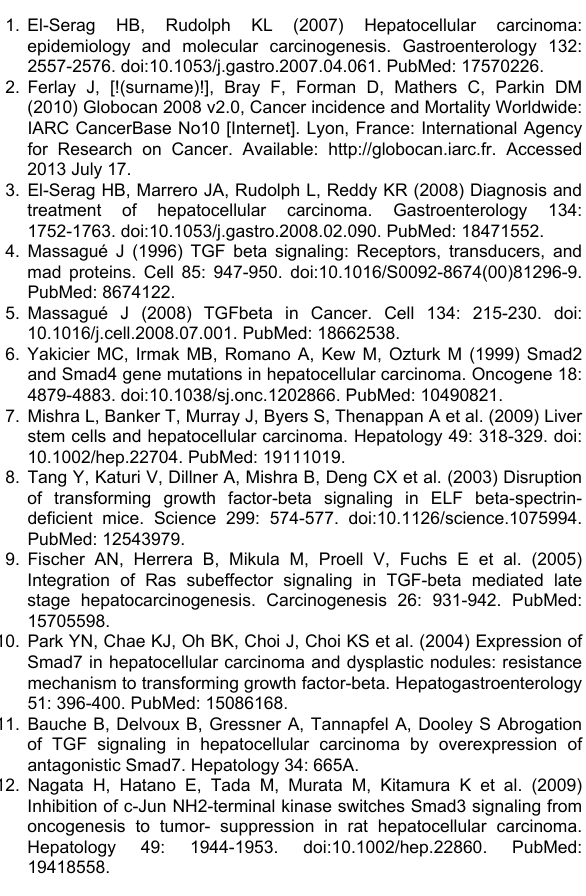
Figure S4. Densitometric analysis (ImageJ software) of Western Blots presented in Figure 3 and corresponding repetitive experiments. Results are shown as mean +/- SE of the indicated numbers of independent experiments.